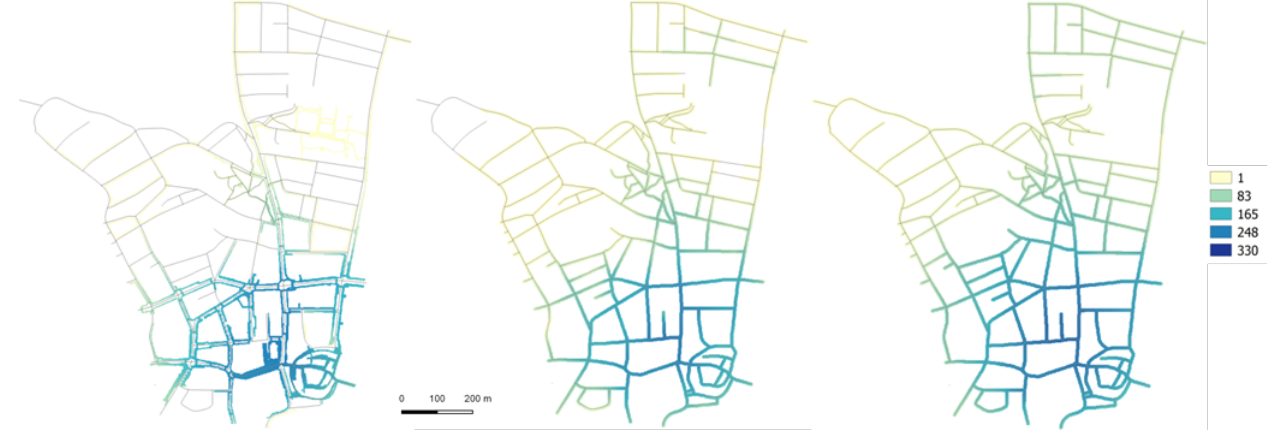
Figure 5. Access-to-destination maps (number of accessible amenities within 400m) calculated based on footpath network 1 comprising car traffic free paths only (left); based on footpath network 2 built from walkability rated streets (middle); and based on unrated street network (right). (Data Sources: Amt für Geoinformation Kanton Solothurn 2016; Direktion für Öffentliche Sicherheit, Stadt